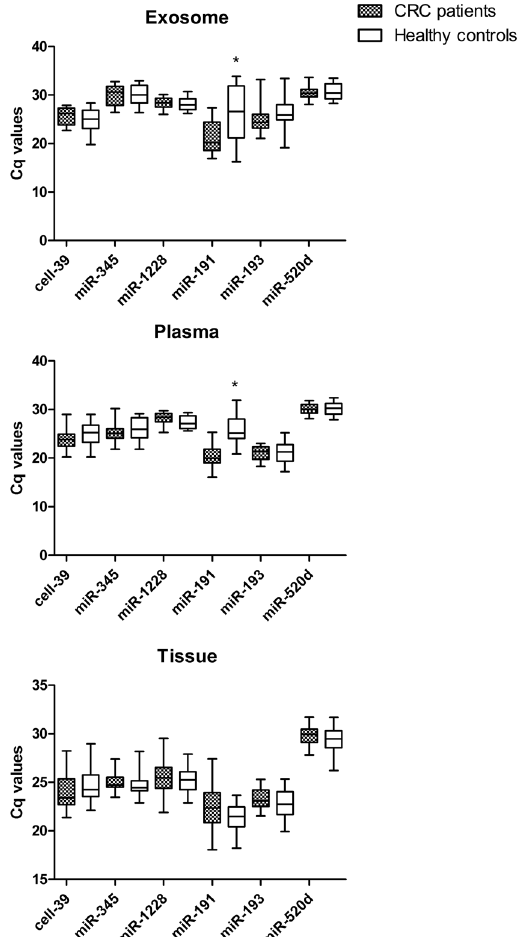
Figure 2. Expression levels of candidate reference miRNAs. Box and whisker plot displaying the Cq values for each putative reference miRNA. There is no significant difference in the expression level of cell-39, miR- 345, miR-1228, miR-193 and miR-520d, between tumour and normal samples in exosomes, plasma and tissue samples. miR-191 showed a significant difference between exosome and plasma samples from CRC and healthy controls (p = 0.015 and p < 0,0001).